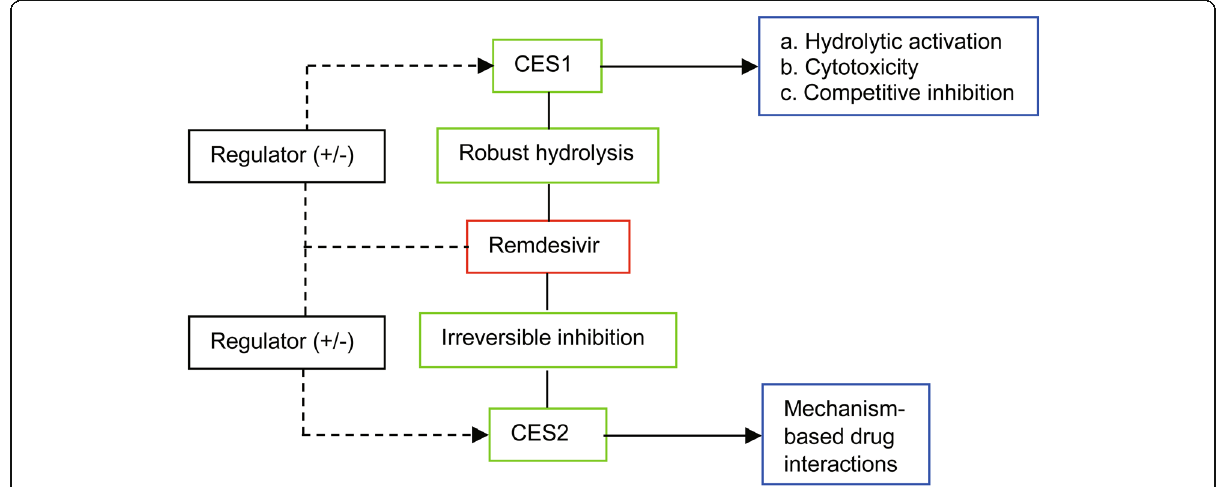
Fig. 3 Diagrammatic presentation of carboxylesterases-based drug interactions with remdesivir. This virial agent is a substrate of CES1 but an irreversible inhibitor of CES2. Therefore, remdesivir catalytically impacts both enzymes (solid lines). In addition, many drugs and other xenobiotic compounds as well as disease mediators such as cytokines are established to regulate the expression of both enzymes. It is assumed that remdesivir has a potential of interacting with those factors (dotted